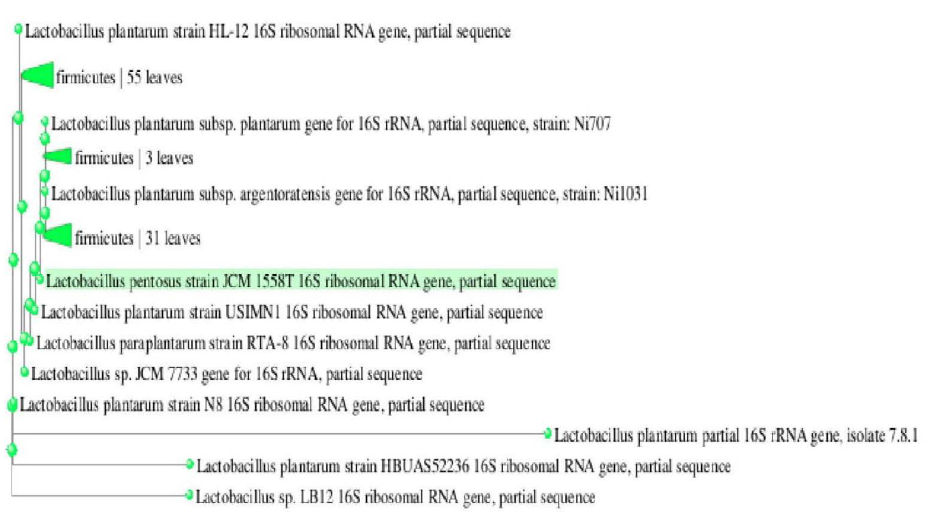
Fig. 4. (A) Phylogenetic dendogram of strain DB2 and related lactic acid bacterial species based on 16S r RNA gene sequence